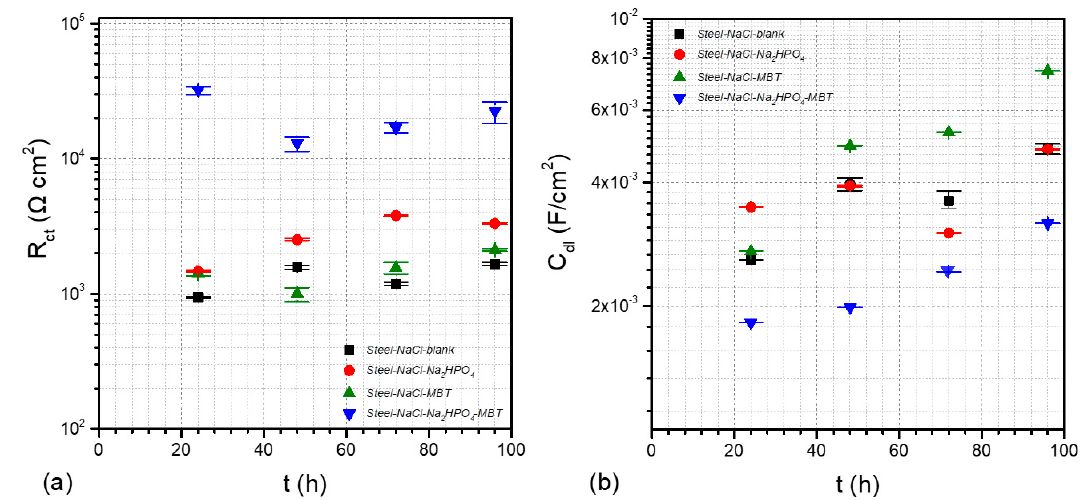
Figure 23. The evolution of the mean values of the EIS fitting parameters as a function of time for mild steel panels after submission in 3.5 wt % NaCl: ( a ) R ct , ( b ) C dl .